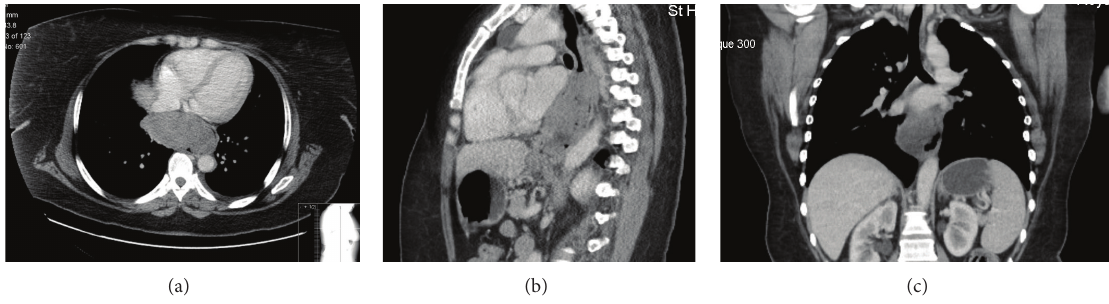
Figure 1: CT scan at presentation: (a) axial view, (b) sagittal view, and (c) coronal